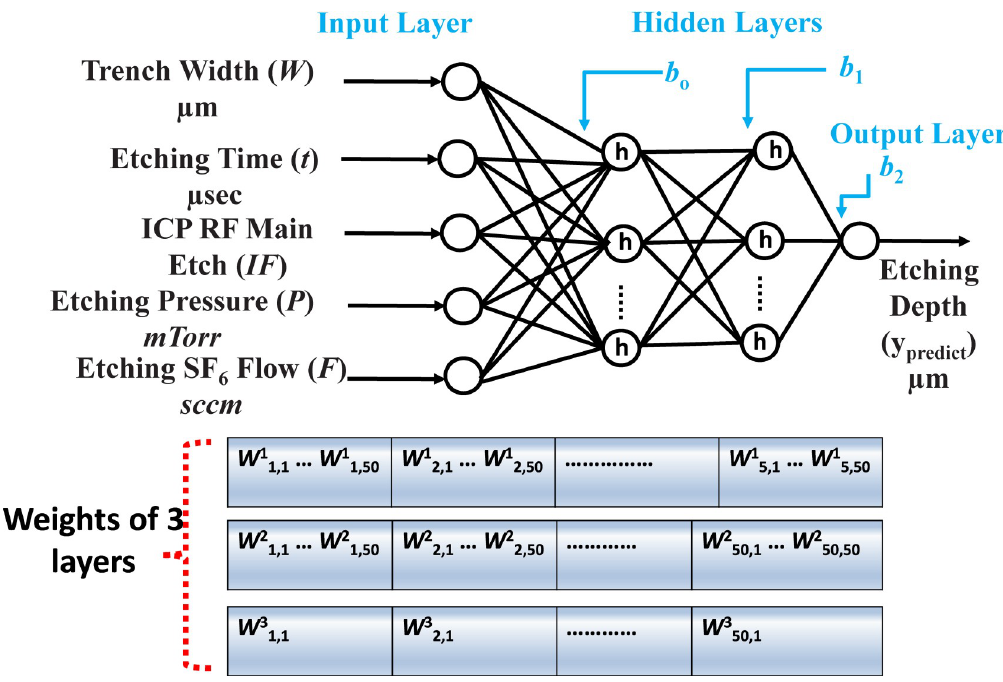
Fig 5. General structure of a four-layer NN with 5 input features, two hidden layers with 50 neurons in each layer, and one output layer.